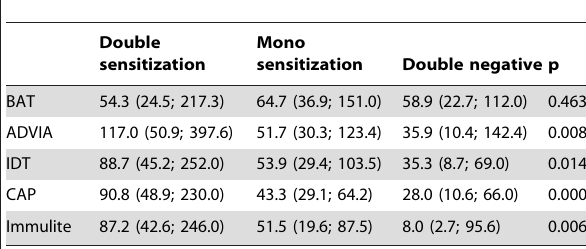
Table 1. Correlation between total IgE (kU/L) and test results.